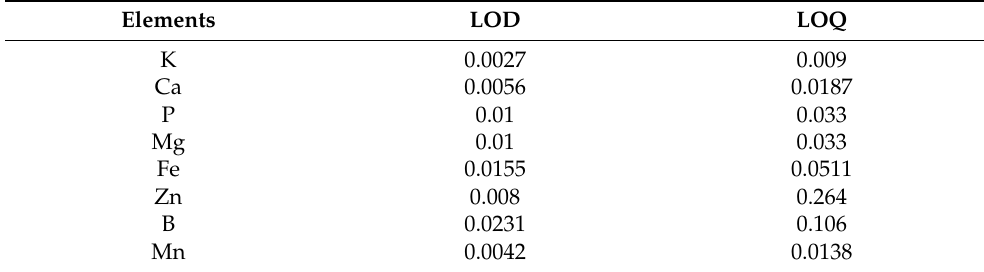
Table 3. LOD and LOQ (mg · kg − 1